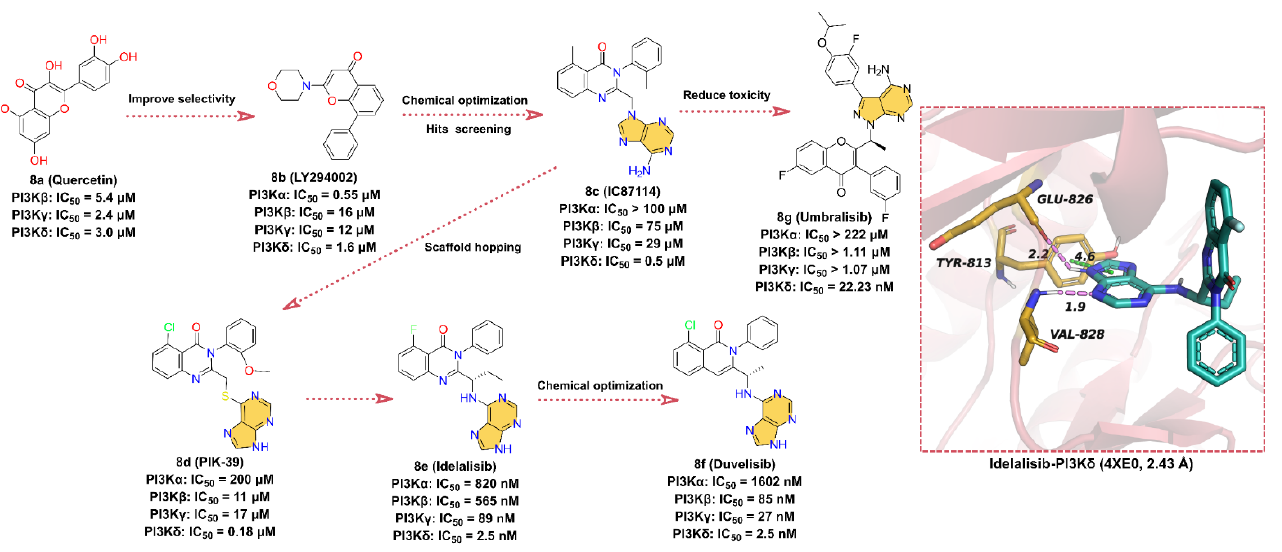
Figure 8. Key medicinal chemistry optimization of PI3K inhibitors along with the binding models with PI3K.